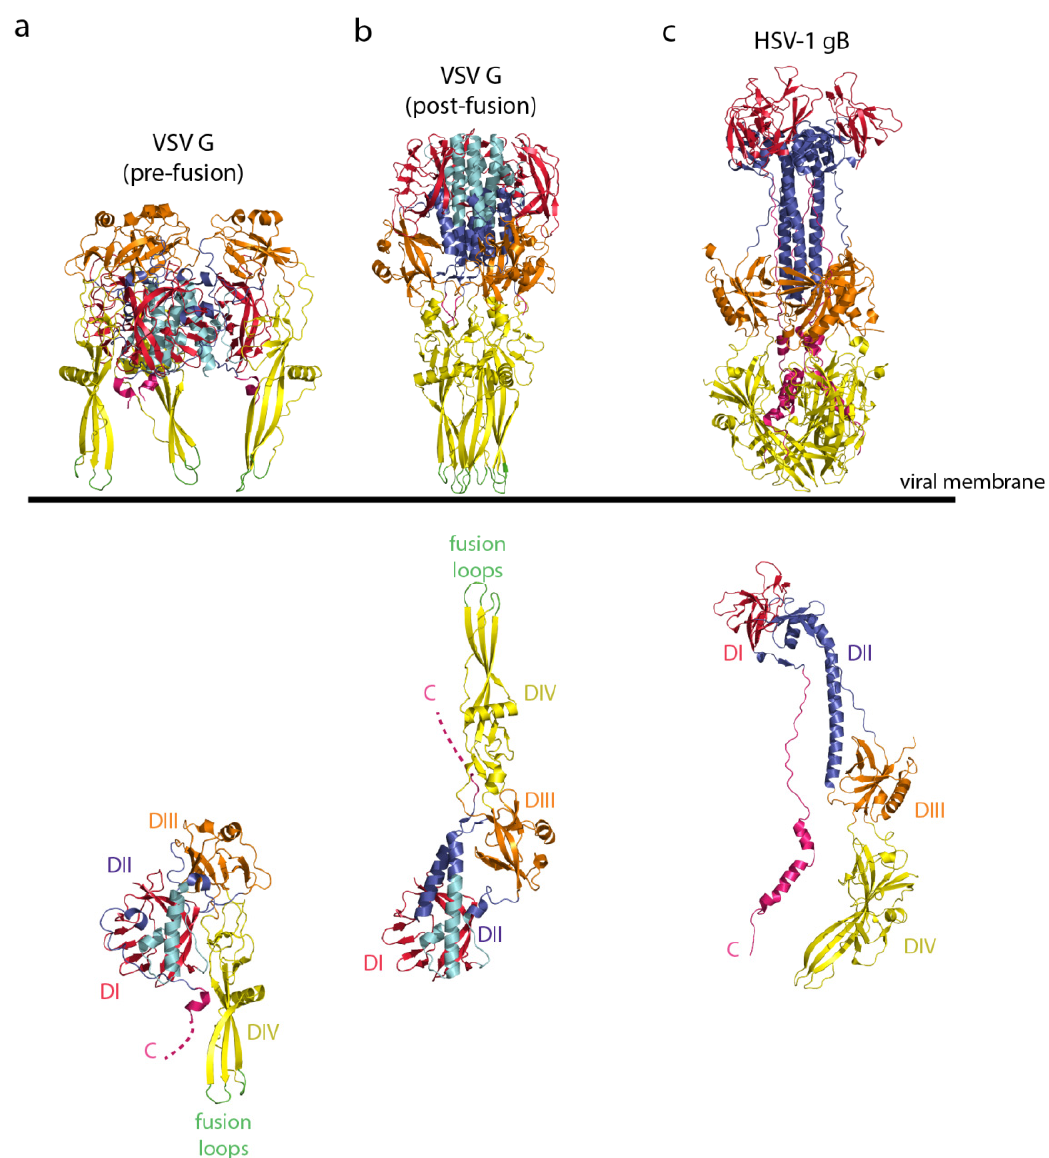
Figure 1. ( a ) Ribbon diagrams of the vesicular stomatitis virus (VSV) glycoprotein (G) pre-fusion trimer (top) and protomer (bottom) (PDB code = 2J6J [73]). ( b ) Ribbon diagram of the VSV G post-fusion trimer (top) and protomer (bottom) (PDB code = 2CMZ [72]). G is depicted by domains; the lateral domain (domain I) is in red, the pleckstrin homology domain (domain III) is in orange, and the fusion domain (domain IV) is in yellow. The trimerization domain is colored with two shades of blue (the part of G that retains its structure during refolding is in cyan, and the part of G that is refolded during the structural transition is in deep blue). The fusion loops are green and the C-terminus is pink. ( c ) Ribbon diagram of the HSV-1 gB trimer (top) and protomer (bottom) (PUB: 2GUM [74]). gB is colored by domains with the same color code as VSV G. The orientation of the VSV G and HSV-1 gB trimers toward the viral membrane is indicated. The VSV G protomers are aligned on the rigid block made of the lateral domain (in red) and the cyan part of the trimerization domain. The orientation of the post-fusion protomer is thus different in the top and the bottom of the